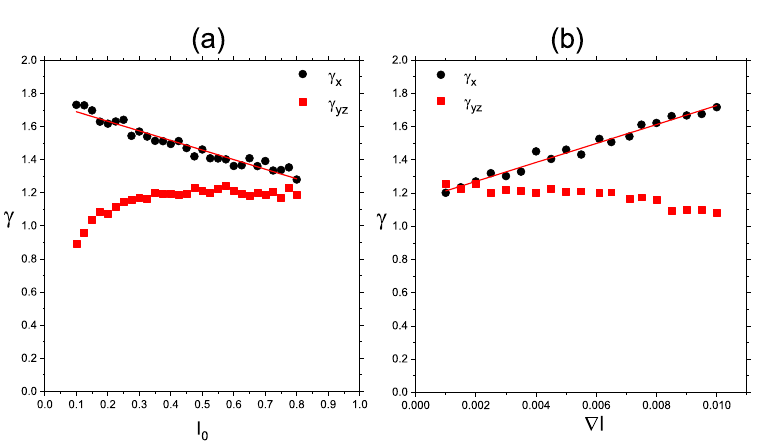
Figure 14. Plot of exponents γ x (black circles) and γ y , z (red squares) as functions of intensity offset I 0 for ∇ I = 0.005 ( a ) and of gradient of intensity ∇ I for I 0 = 0.5 ( b ). T = 0.25. The dynamics of a chain depends on its length (number of monomers N